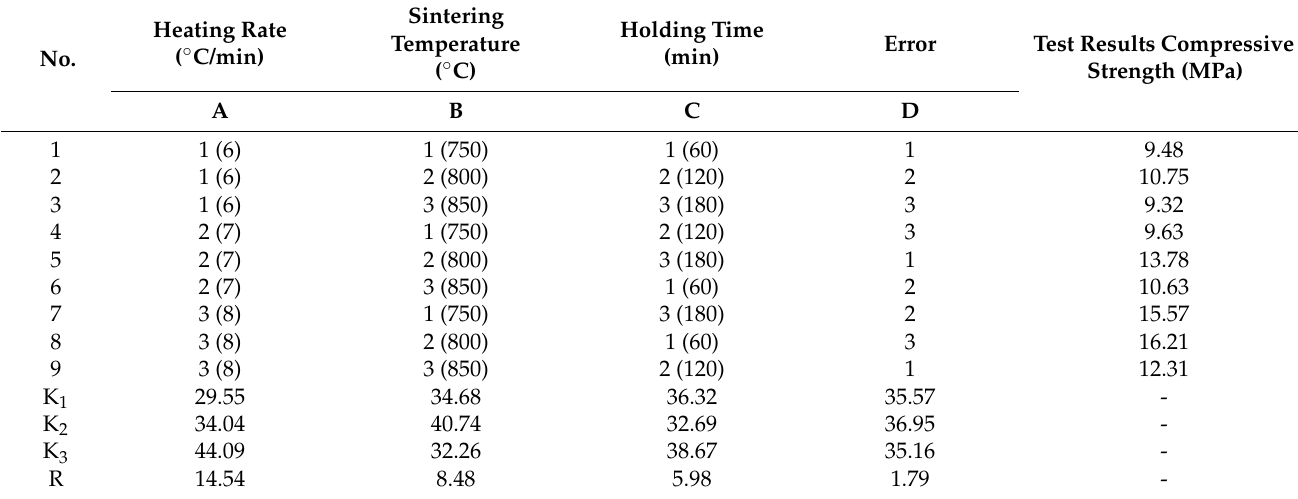
Table 3. The orthogonal pilot programs and experimental results.